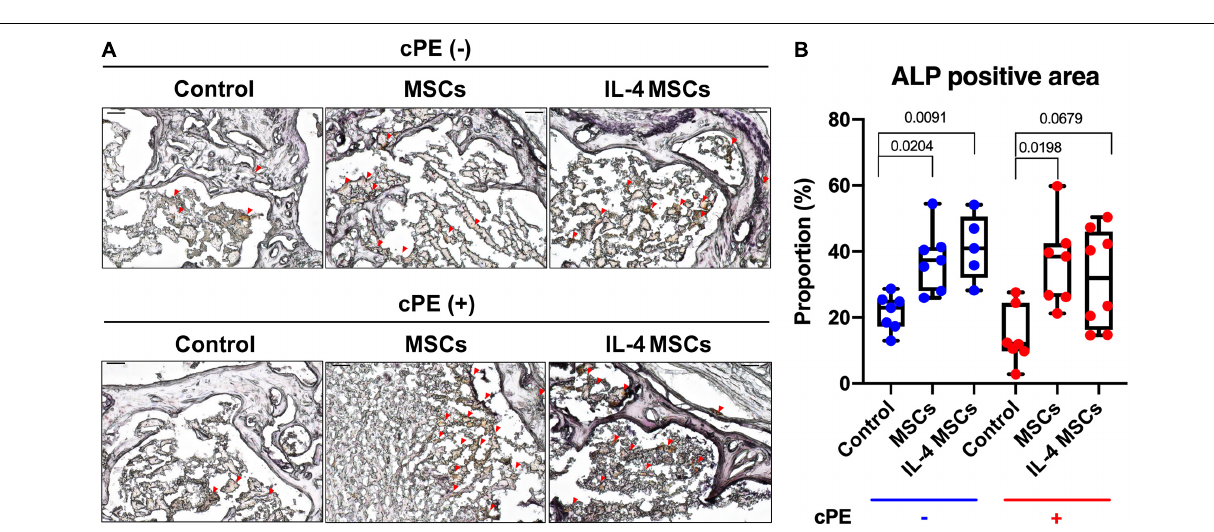
FIGURE 6 | ALP staining of all the groups. (A) Representative images of ALP staining, red arrows point the ALP positive area. (B) Quantitative analysis of ALP positive proportion. (cPE- control group: n = 7; cPE- MSCs group: n = 7; cPE- IL-4 MSCs group: n = 5; cPE + control group: n = 7; cPE + MSCs group: n = 7; cPE + IL-4 MSCs group: n =